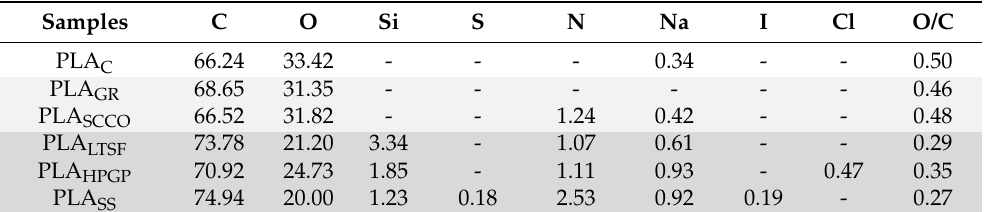
Table 3. Elemental composition of untreated PLA and after sterilisation treatments obtained from XPS analysis (at. %).